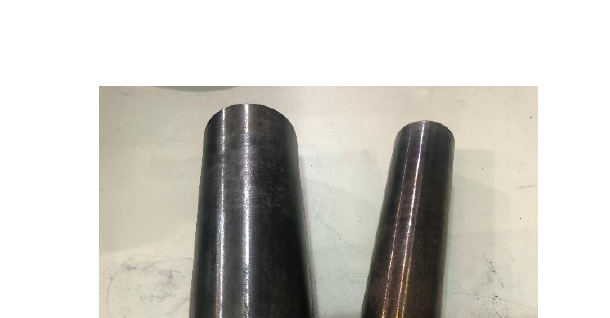
Figure 1. Device for the compaction of the anode paste. ( a ) Rigid die; ( b ) MTS Servohydraulic press. The heating program, as shown in Figure 2, was used for the TGA analysis, the dila- tometry, the air permeability, and the helium-pycnometric measurements. The red dashed line corresponds to the heating program of the TGA analysis, where the samples were baked up to 1000 °C. Blue circles correspond to given target temperatures * T . Samples